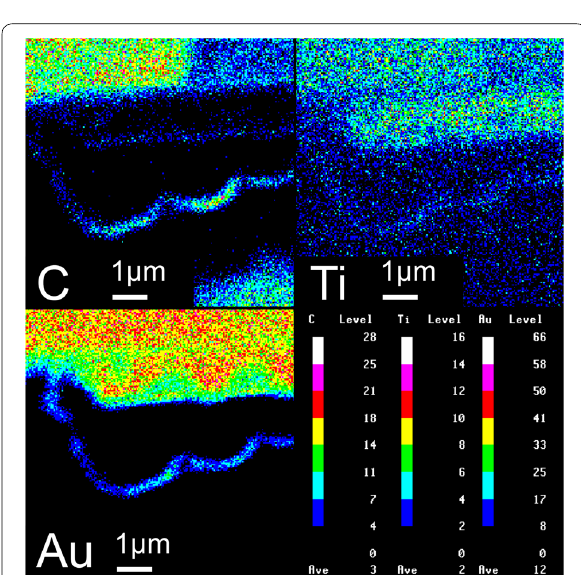
Fig. 6 Wavelength‑dispersive spectroscopy analysis results for the unintended burr shown in Fig. 5